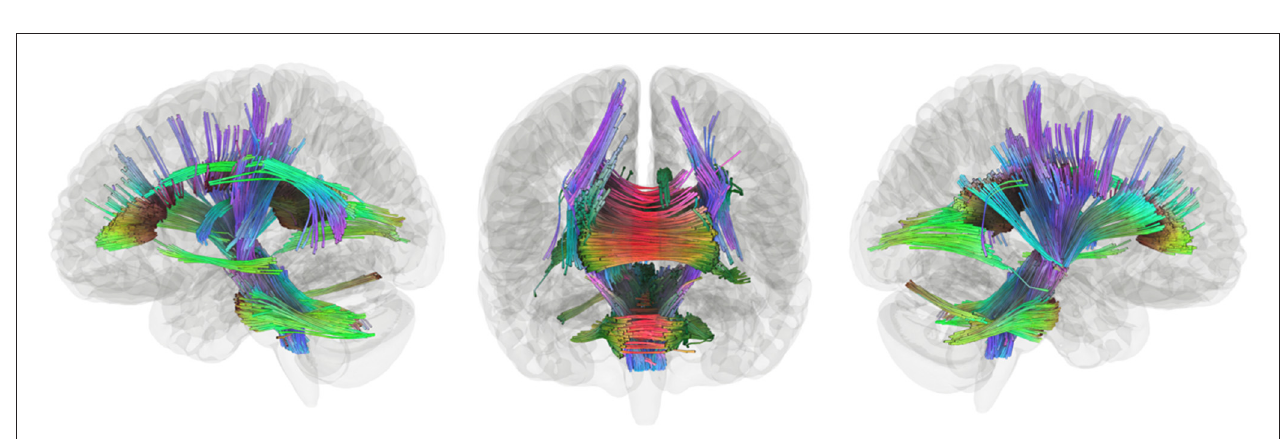
FIGURE 3 | Tracks positively associated with composite language performance within TC group. Tracts that were positively correlated with language performance, controlling for WNV, within TC (t = 2.5, length threshold = 20 voxels, FDR = 0.05, 4,000 permutations, 2 rounds of tract trimming). Results include bilateral corticospinal tract, much of the corpus callosum, middle cerebellar peduncle, left arcuate fasciculus, left inferior longitudinal fasciculus, and left cingulum.